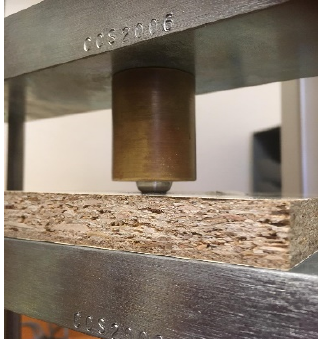
Figure 2. Hardness measurement of overlaid particleboard (PB).